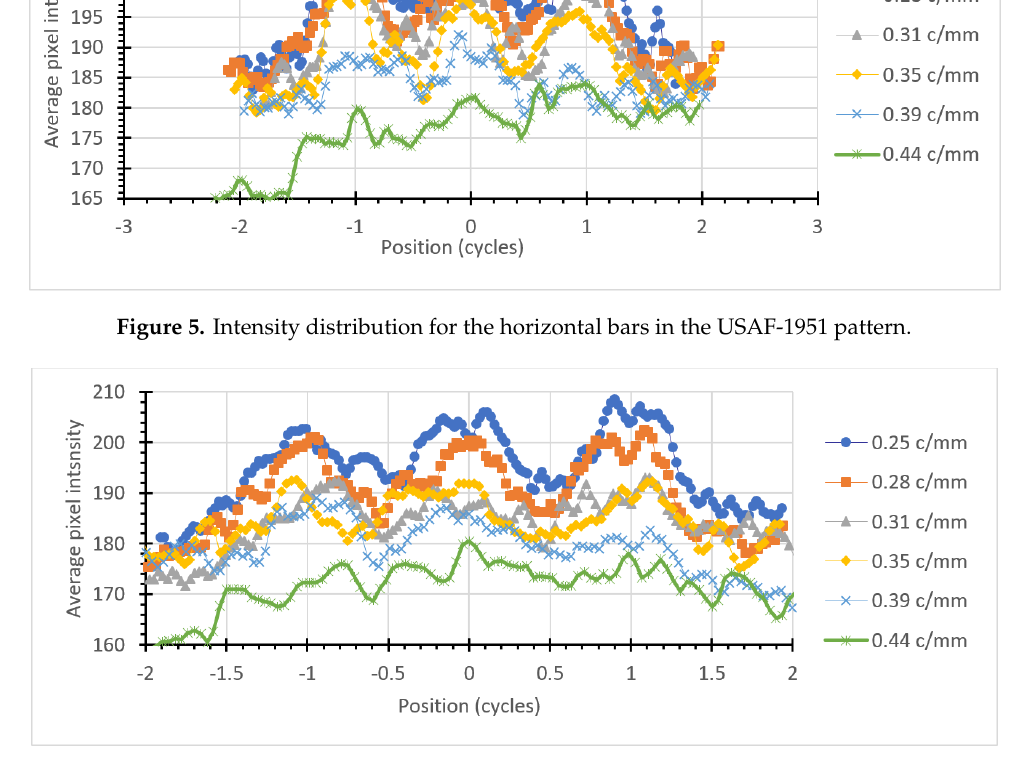
Figure 6. Intensity distribution for the vertical bars in the USAF-1951 pattern.